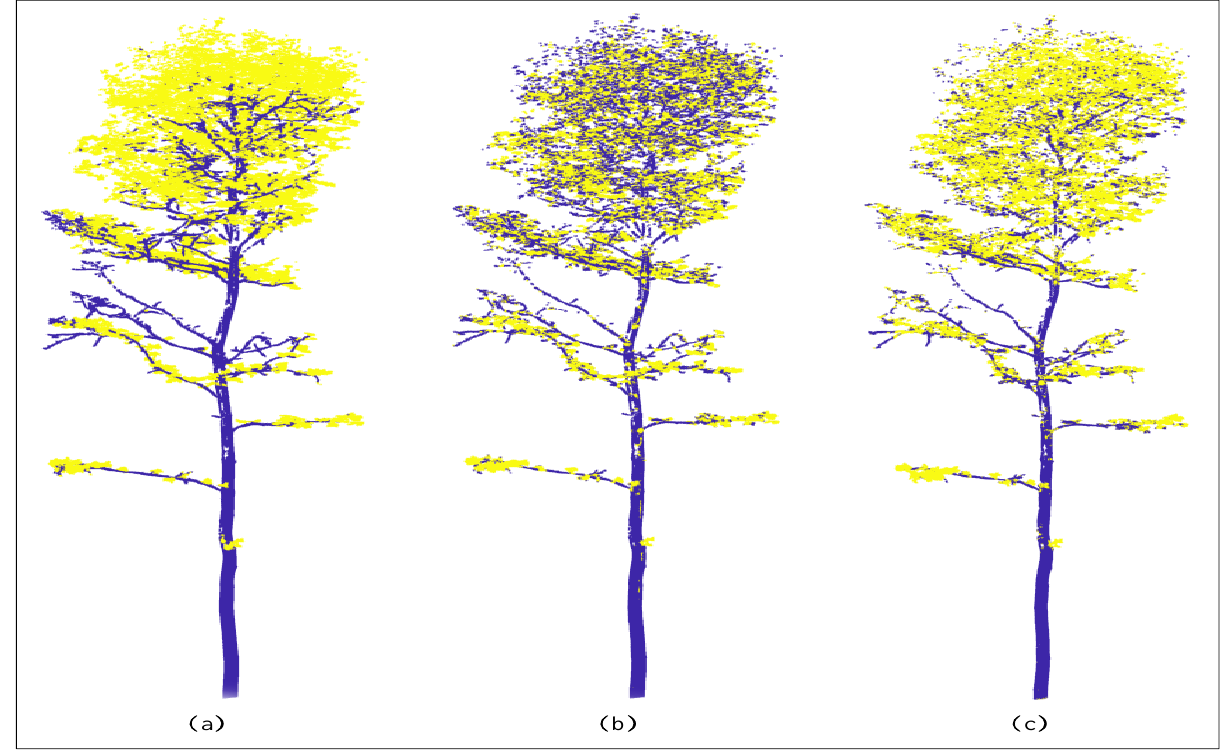
Figure 2. The point cloud of tree 2. (a) the manually classified point cloud; (b) the classification result of single-scale method ( r = 0.14m); (c) the classification result of multi-scale method ( r =